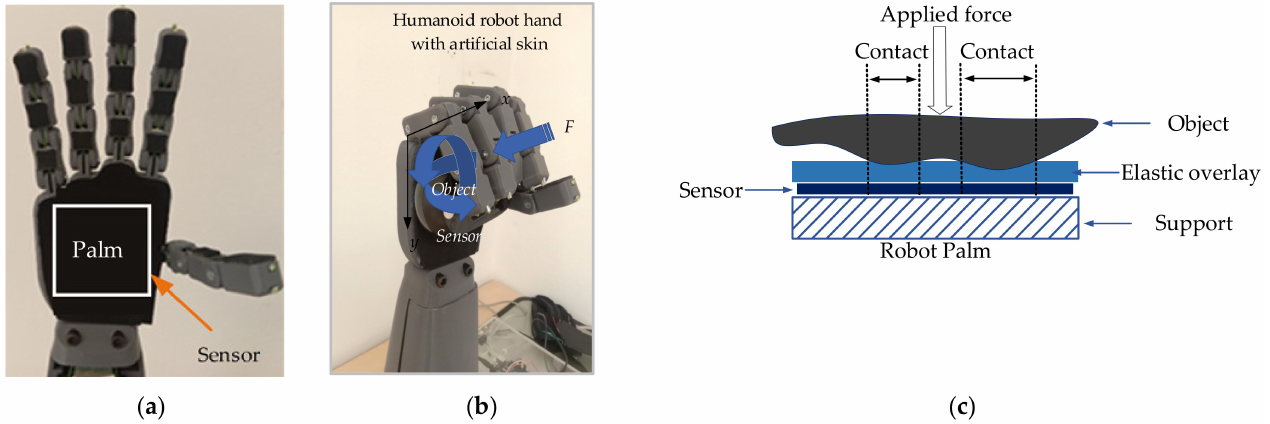
Figure 11. Experimental setup: ( a ) A humanoid robot hand equipped with a tactile sensor array on the palm; ( b ) A humanoid robot hand during object handling; ( c ) Force-sensing transducer of the tactile sensor